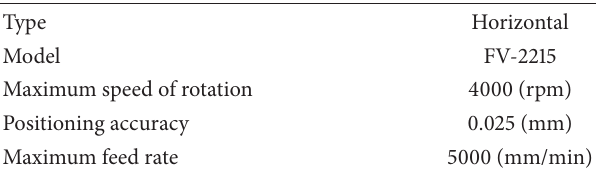
Table 2: Characteristics of the machining